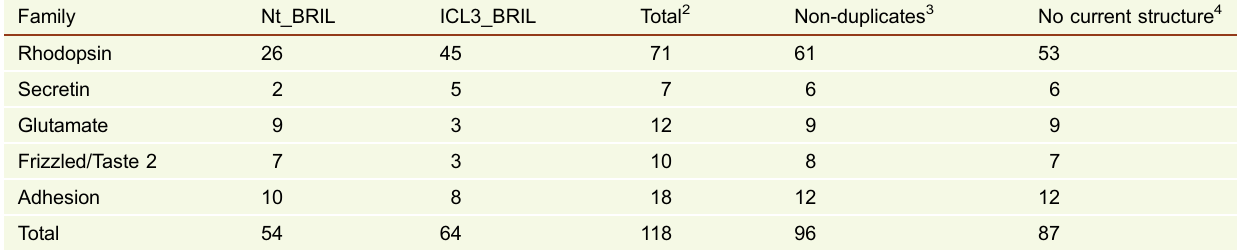
Table 3. High expressing GPCR constructs by family 1